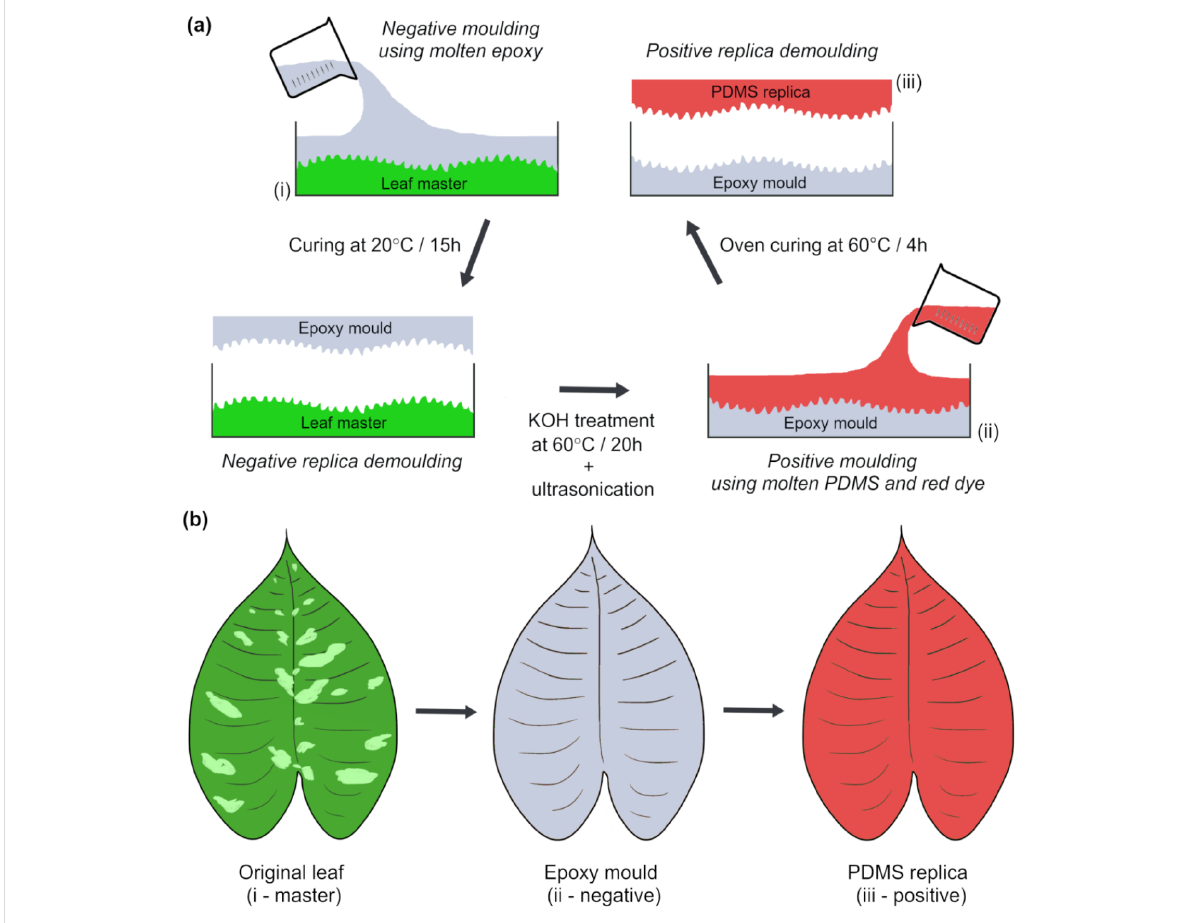
Figure 7: Schematic representation of (a) the replication process of Schismatoglottis calyptrata leaf surfaces and (b) original, epoxy negative and PDMS positive replicas. The leaves at stages 1 and 2 were unrolled for replication and the adaxial side of the leaves at all stages were replicated.